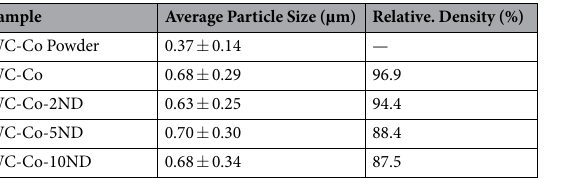
Table 1. Relative density and average WC particle size in WC-Co powders and consolidated